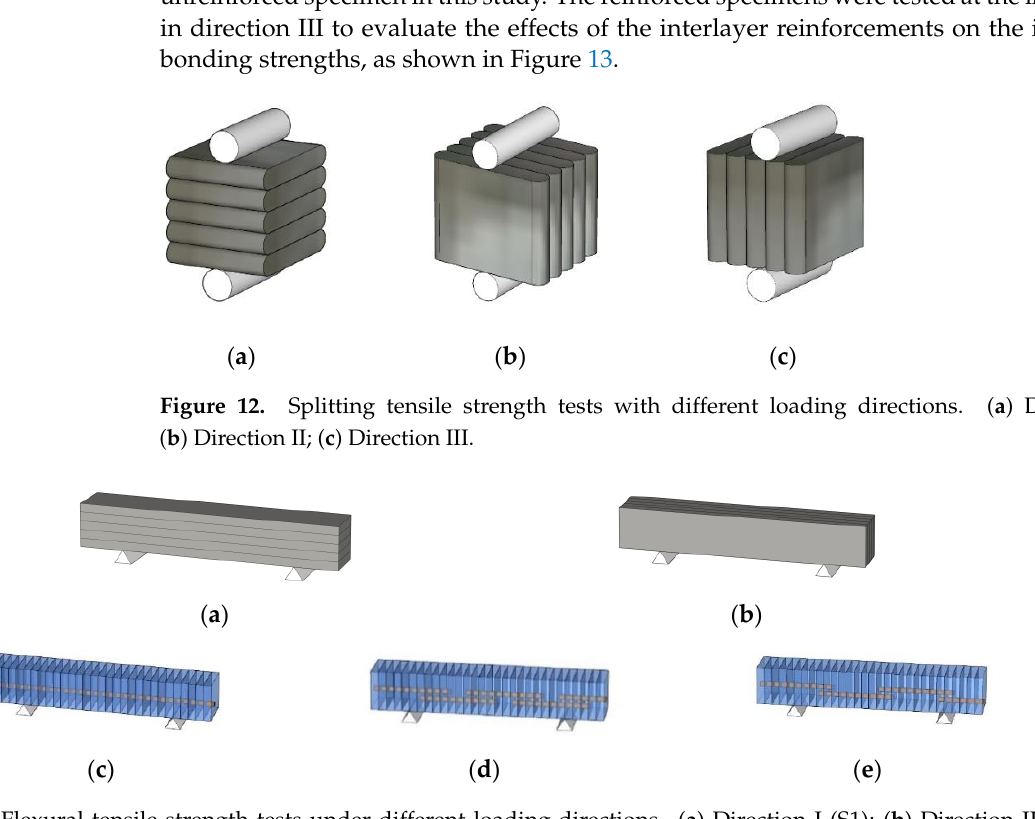
Figure 11. Test methods for splitting tensile strength. ( a ) Cylindrical specimen; ( b ) Cubic specimen (Case I); ( c ) Cubic specimen (Case II).